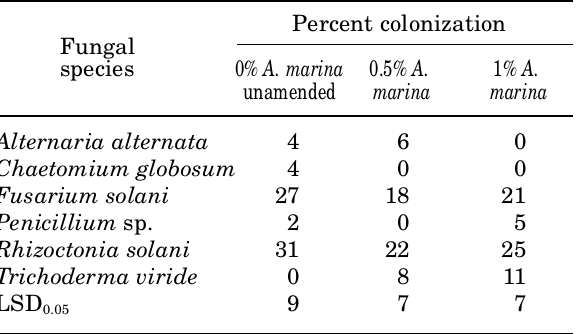
Table 4. Percent colonization of mungbean roots grow- ing in soils amended with different A. marina amend- ments (0.5 and 1%) and in unamended soil by fungi de- tected in the plant